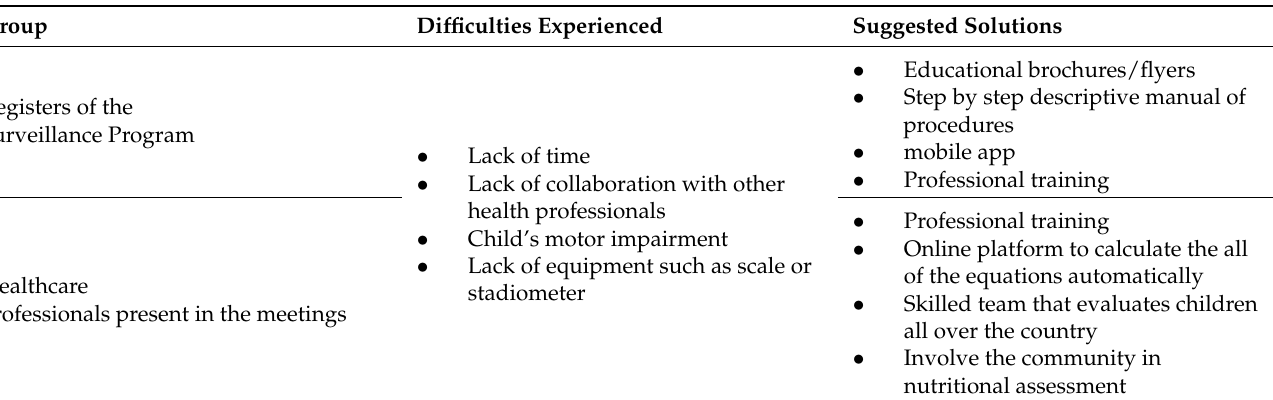
Table 1. Difficulties experienced by registers and healthcare professionals and suggest strategies to improve nutritional